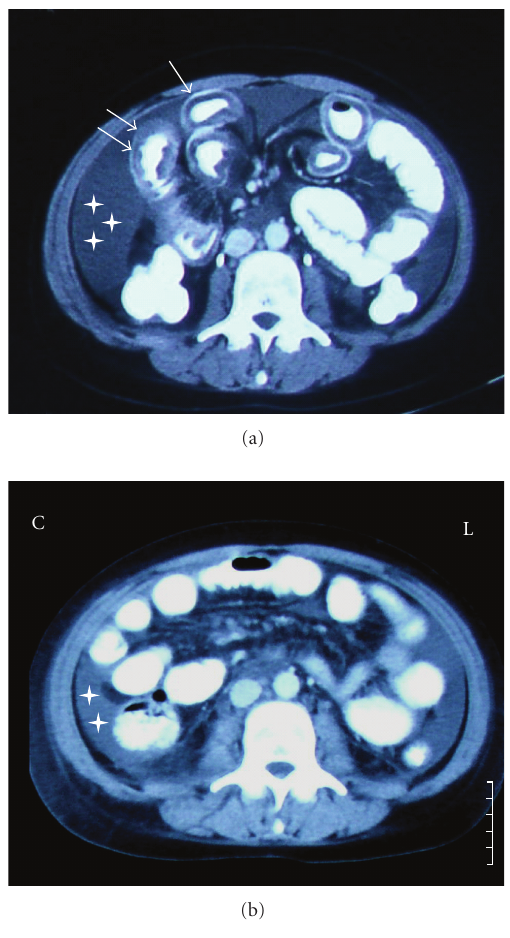
Figure 1: Computed tomography scan of the abdomen performed. (a) On day 3 of the patient’s admission, 4 days after initiation of symptoms. Arrows: thickening/dilatation of the intestinal wall, stars: ascitic fluid. (b) Four days after initiation of treatment, with marked improvement of the intestinal morphology, and moderate reduction of the amount of ascitic